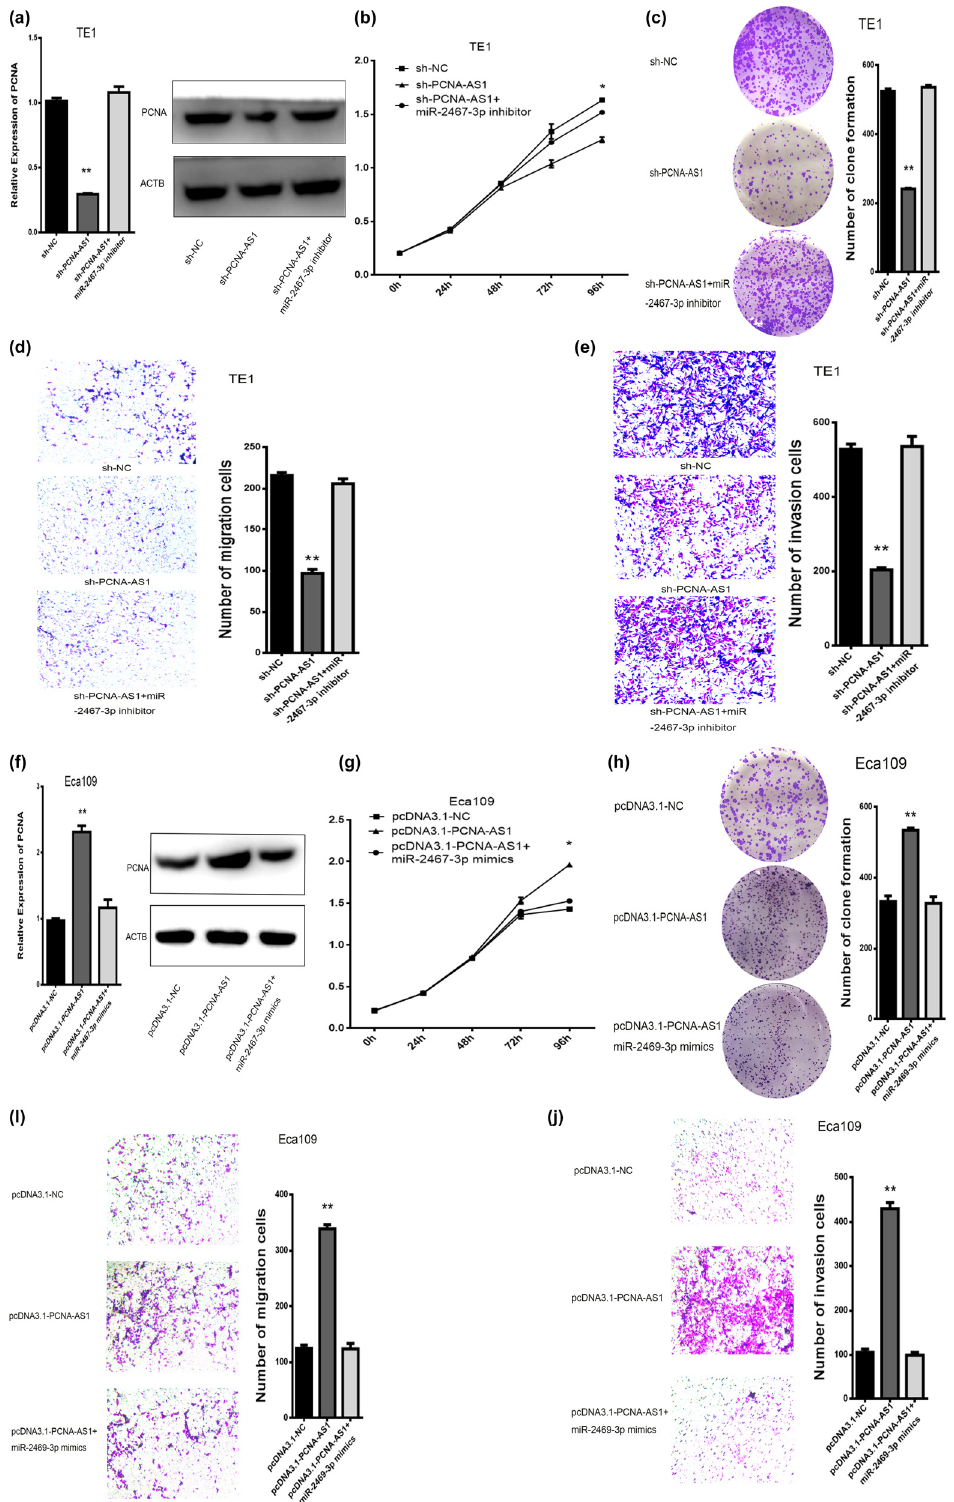
Figure 6: PCNA - AS1 regulates PCNA in a miR - 2467 - 3p manner in ESCC cells. ( a – e ) The e ff ects of sh - PCNA - AS1 or sh - PCNA - AS1/miR - 2467 - 3p inhibitor co - transfection on the cell viability, migration, clone formation and invasion in the TE1 cells. ( f – j ) The e ff ects of pcDNA3.1 - PCNA - AS1 or pcDNA3.1 - PCNA - AS1/miR - 2467 - 3p mimics co - transfection on the cell viability, migration, clone formation and invasion in the TE1 cells. *P < 0.05 and **P <